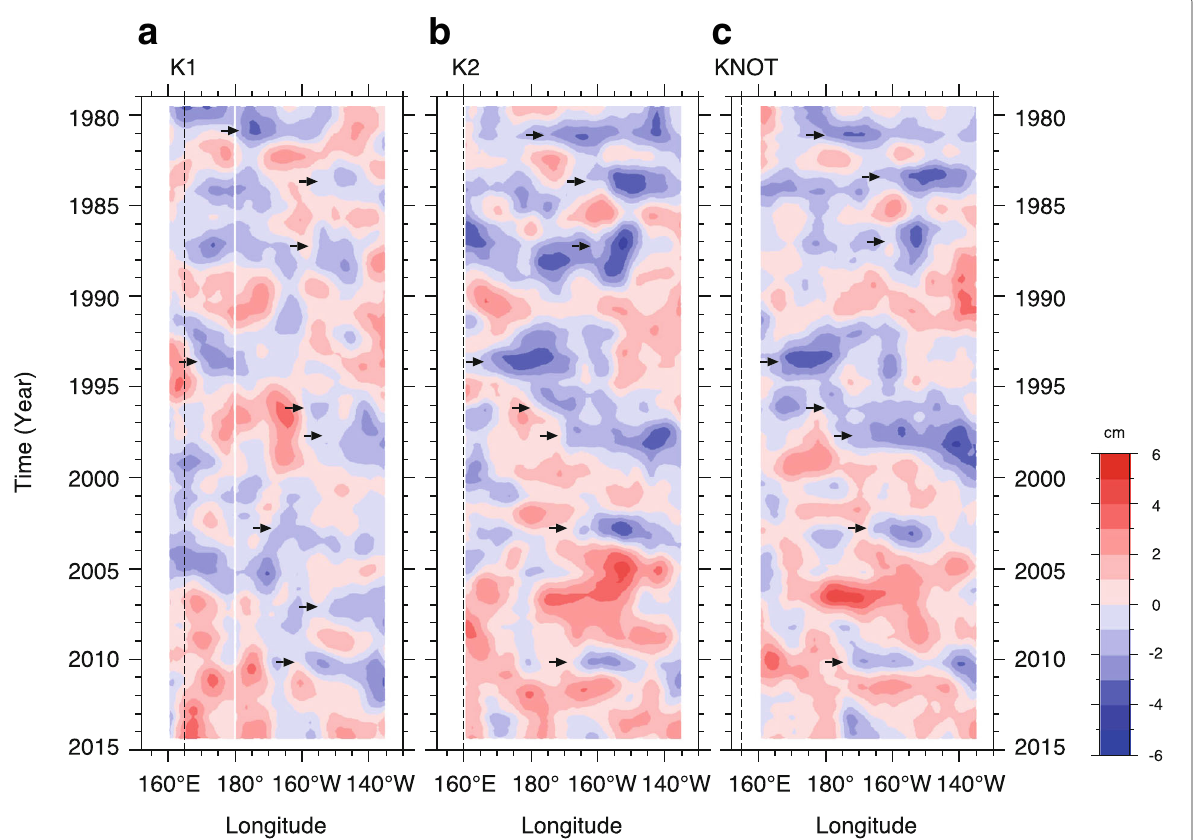
Fig. 15 a – c Same as Fig. 9 but for the SSH variations due to the baroclinic Rossby wave modes ( n = 1, 2, 3, and 4) forced by the wind stress. Arrows show El Niño-related SSH depressions. In panel a , the wind stress data in the region east of 180° were not used for the calculation of the SSH anomaly in the western